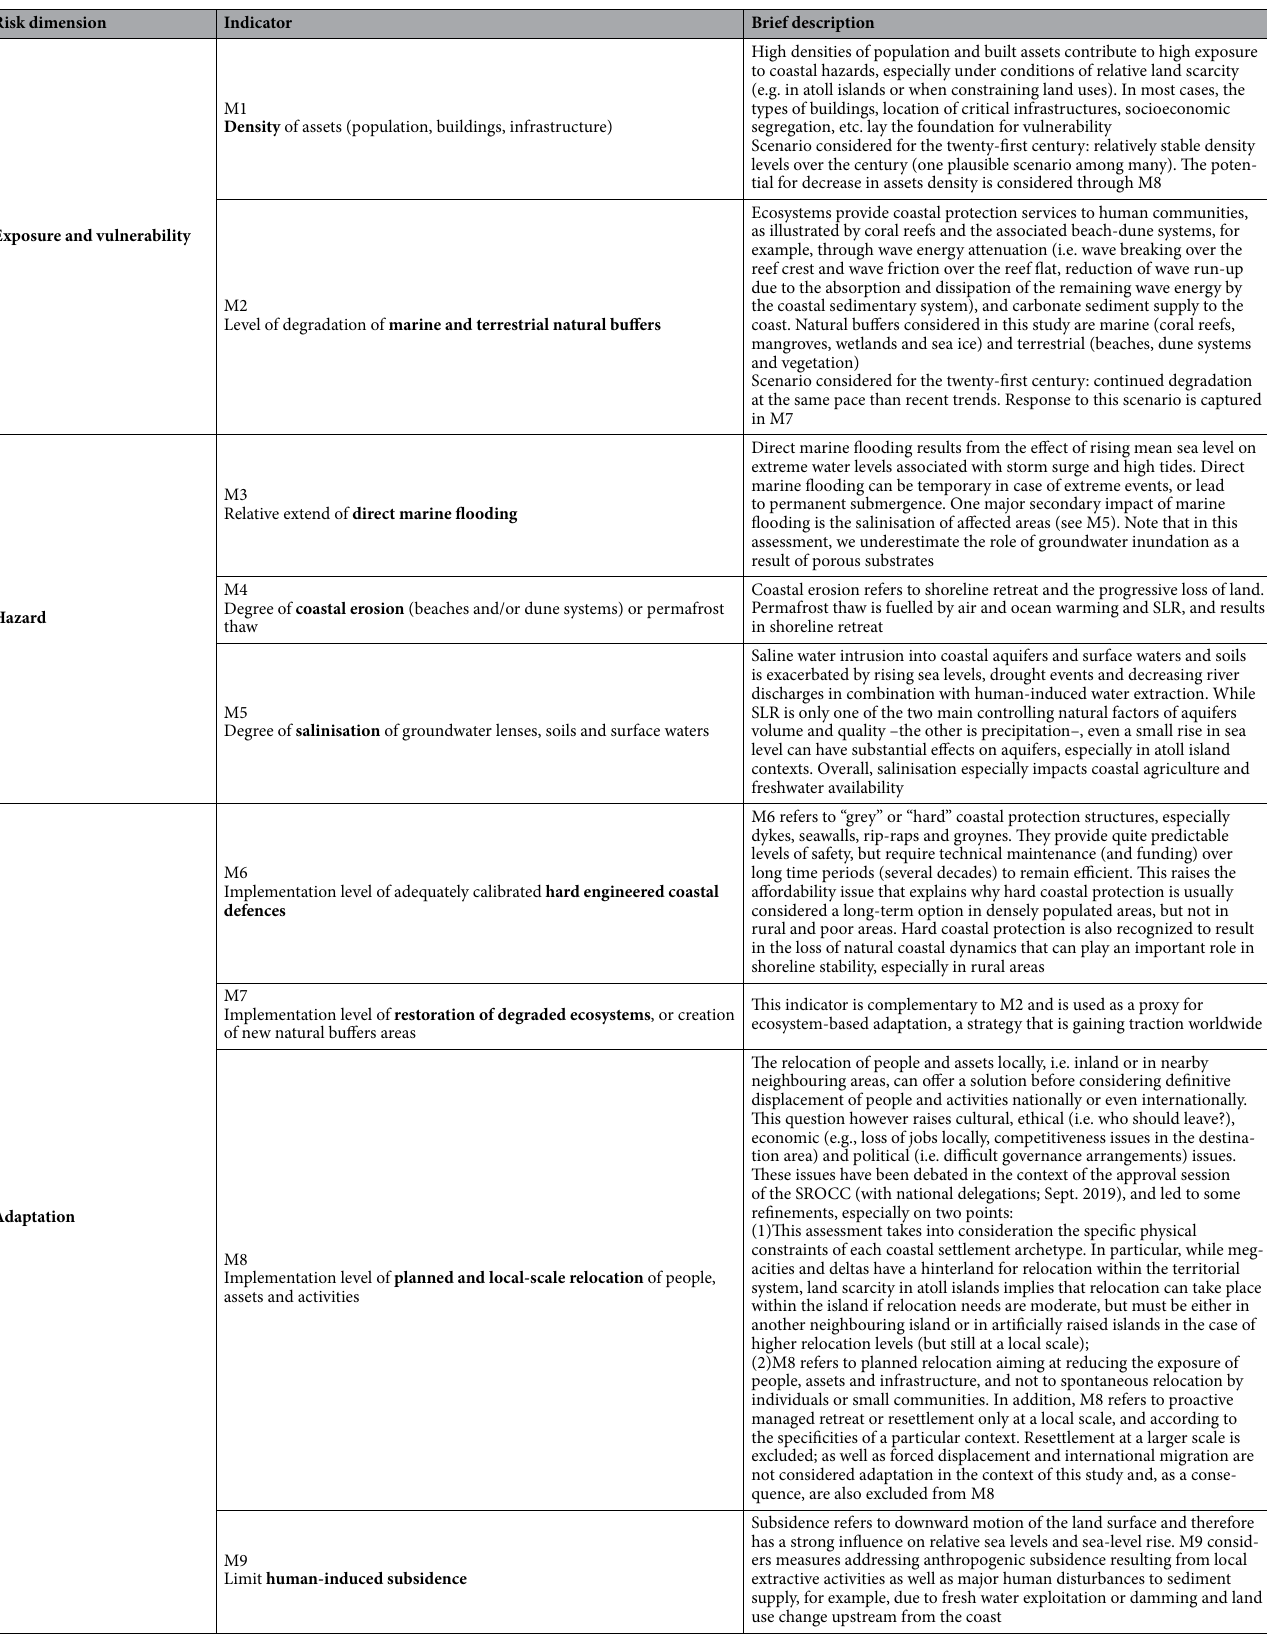
Table 3. The indicators used in this risk assessment. See “Methods” section for